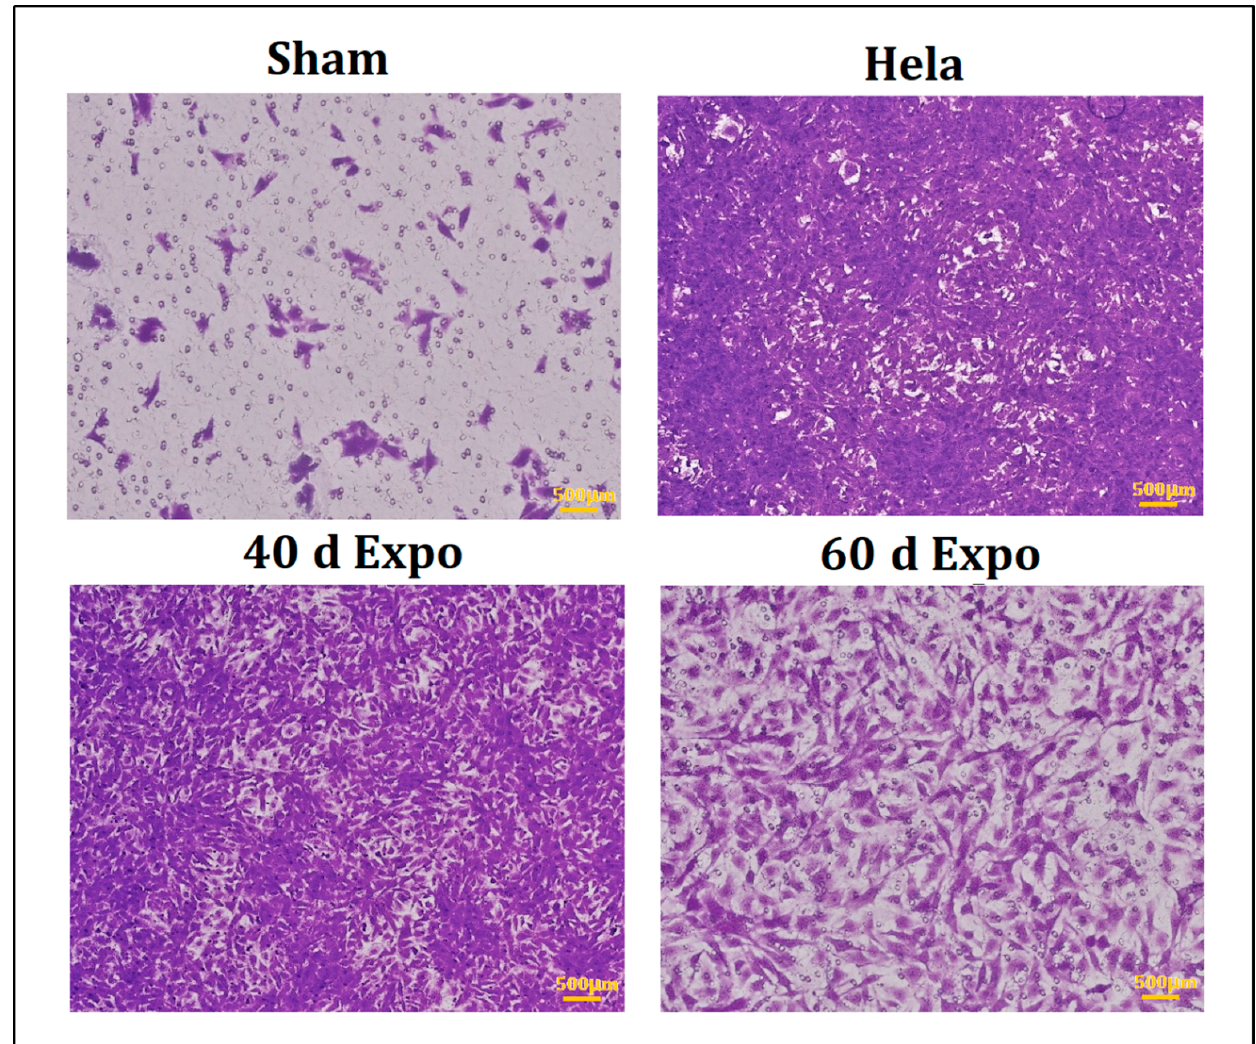
Figure 3. Transwell assay of Balb/c-3T3 cells after exposure. The 40-day expo and 60-day Balb/c-3T3 cells showed strong migration ability after 24 h incubation. The HeLa cells were used as the positive control group.